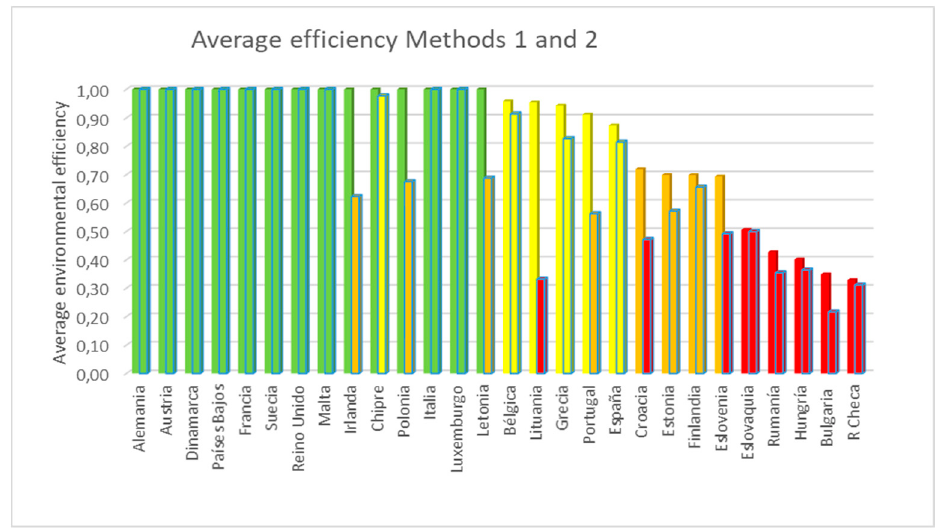
Figure 3. Average environmental efficiencies for the 28 countries (2005–2012), being the bars on the left the efficiency with Method 1 and the right bar efficiency with Method 2. Source: own